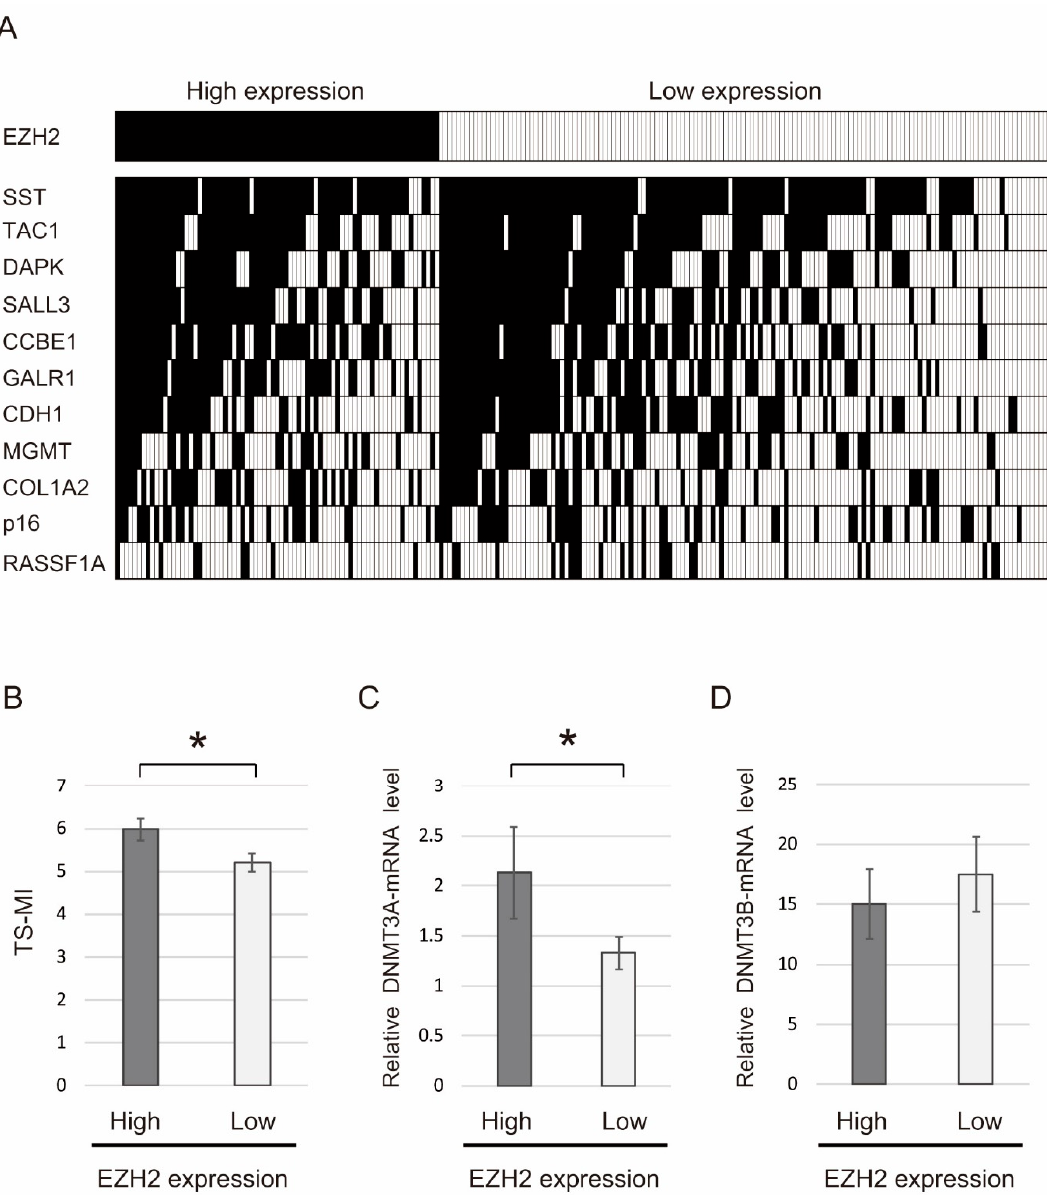
Figure 3. Comparison of methylation rates in 11 tumor suppressor genes along with EZH2 expression in 230 primary head and neck squamous cell carcinoma (HNSCC) tissues. ( A ) Distribution of EZH2 gene expression status and 11 tumor suppressor genes promoter methylation. Shaded boxes indicate the presence of methylation; open boxes, the absence of methylation. ( B ) Correlation between the methylation index of tumor suppressor genes (TS-MI) and EZH2 gene expression status in HNSCC patients ( p = 0.032). The mean tumor suppressor genes (TS-MI) for the different groups were compared using a student’s t-test. ( C ) DNMT3A mRNA was significantly upregulated in groups displaying EZH2 upregulation ( p = 0.032). ( D ) DNMT3B expression was not associated with EZH2 expression status ( p = 0.628). * p < 0.05.